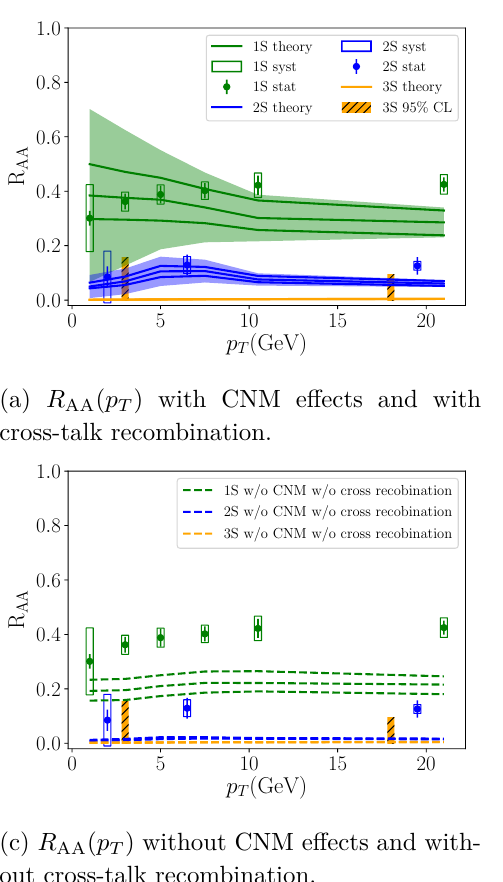
Figure 4. Bottomonia R AA as functions of transverse momentum and rapidity at 5 . 02 TeV Pb-Pb collisions. The upper and lower curves correspond to calculations with parameters that differ by ± 10% respectively from the parameters used in the middle curve. The band indicates the nPDF uncertainty that is centered at the middle curve. Experimental data are taken from ref.